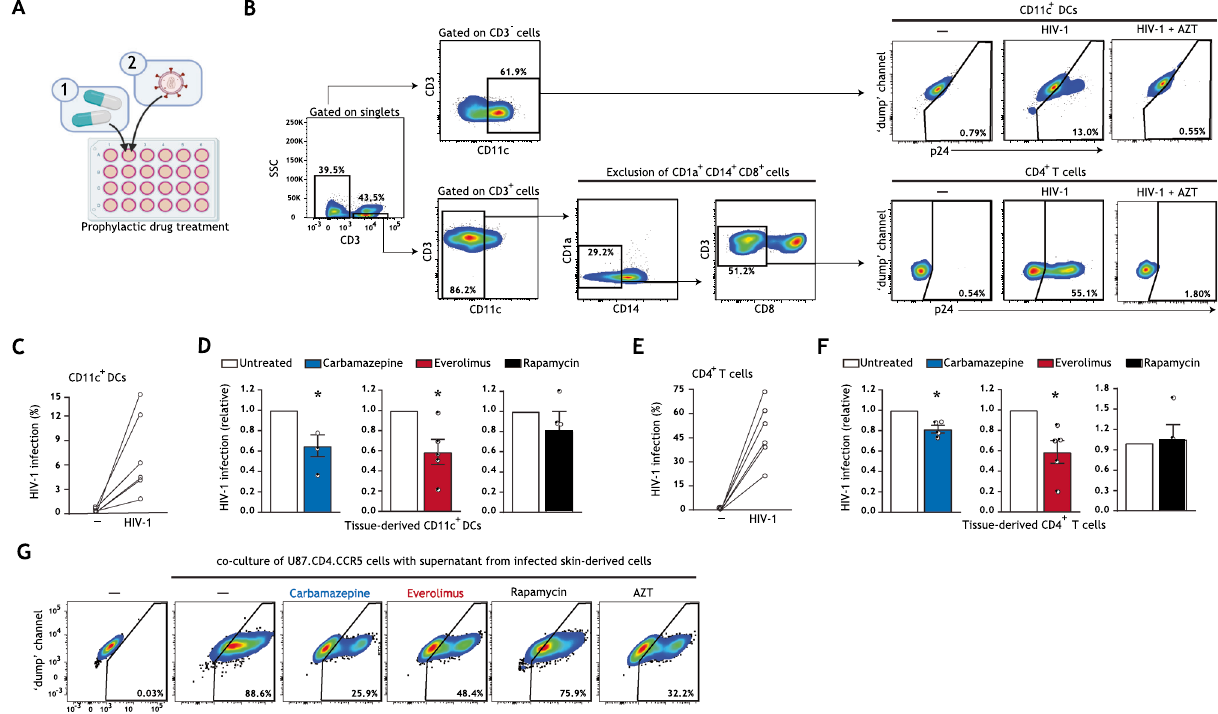
Figure 2. Prophylactic treatment with autophagy drugs reduces HIV-1 acquisition by tissue-derived DCs and CD4 + T cells. ( A ) Brief schematic representation of the novel HIV-1 tissue infection model for drug screening; an extended graphical representation of the prophylactic treatment model is available in Figure S3A, Supplementary Information. Biopsies including epithelium and subepithelium were taken from skin and cultured in a 24 well plate. Skin biopsies were prophylactically treated with autophagy drugs and subsequently infected with HIV-1. HIV-1 infection of different cell types and subsets was quantified using multiparameter flow cytometry. ( B ) Gating strategy utilized to discriminate HIV-1 infection in the emigrated CD11c + DCs and CD4 + T cells. Treatment of tissue biopsies with HIV-1 replication inhibitor AZT (zidovudine, 20 μM) confirmed productive HIV-1 infection of these cell types. A detailed gating strategy can be found in Figure S4, Supplementary Information. ( C – F ) Human tissue biopsies were prophylactically treated with carbamazepine (100 μM), everolimus (5 nM), or rapamycin (100 nM) for 15 h, or left untreated, and subsequently infected with HIV-1 NL4.3BaL for 48 h. Emigrated cells were then harvested, washed, and replated for an additional 72 h. HIV-1 infection of emigrated CD11c + DCs was determined as the percentage of CD3 − CD11c + p24 + cells ( C , D ), and HIV-1 infection of emigrated CD4 + T cells as the percentage of CD3 + CD11c − CD14 − CD1a − CD8 − p24 + cells ( E , F ), determined by flow cytometer. ( C – F ) Data are mean ± SE of n = 4–5 donors measured in duplicate. Open circles represent the mean of duplicates from each independent experiment. ( D , F ) Untreated HIV-1 infected cells was set at 1 * P < 0.05; one-sample t test. ( G ) Skin biopsies including epithelium and subepithelium were prophylactically treated for 15 h with autophagy drugs carbamazepine (100 μM), everolimus (5 nM), rapamycin (100 nM), HIV-1 replication inhibitor AZT (zidovudine, 20 μM), or left untreated, followed by infection with HIV-1 NL4.3BaL. 36 h post-infection, emigrated tissue-derived cells were extensively washed to remove input virus, and replated in new medium in a 96-well plate. Supernatant from infected tissue-derived cells was collected 120 h after replating and co-cultured with U87.CD4.CCR5 cells for 72 h, to further confirm productive HIV-1 infection. A detailed graphical representation of this extracellular virus release assay is available in Figure S3B, Supplementary Information. HIV-1 infection of U87.CD4.CCR5 cells was determined by intracellular p24 staining by flow cytometer. Representative (n = 2 tissue donors) flow cytometry plots of HIV-1 infection of U87.CD4.CCR5 cells incubated with supernatants from HIV-1 infected skin-derived cells is